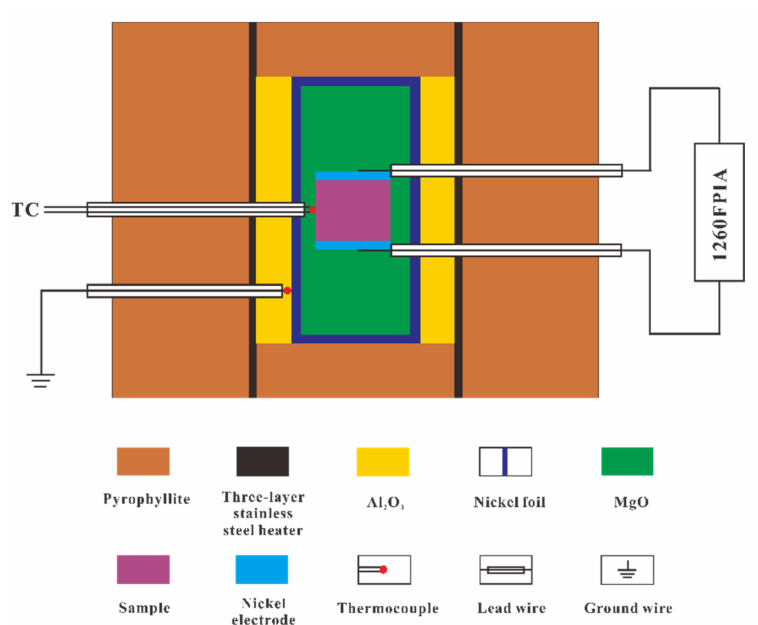
Figure 3. The experimental setup for electrical conductivity measurements at high temperature and high